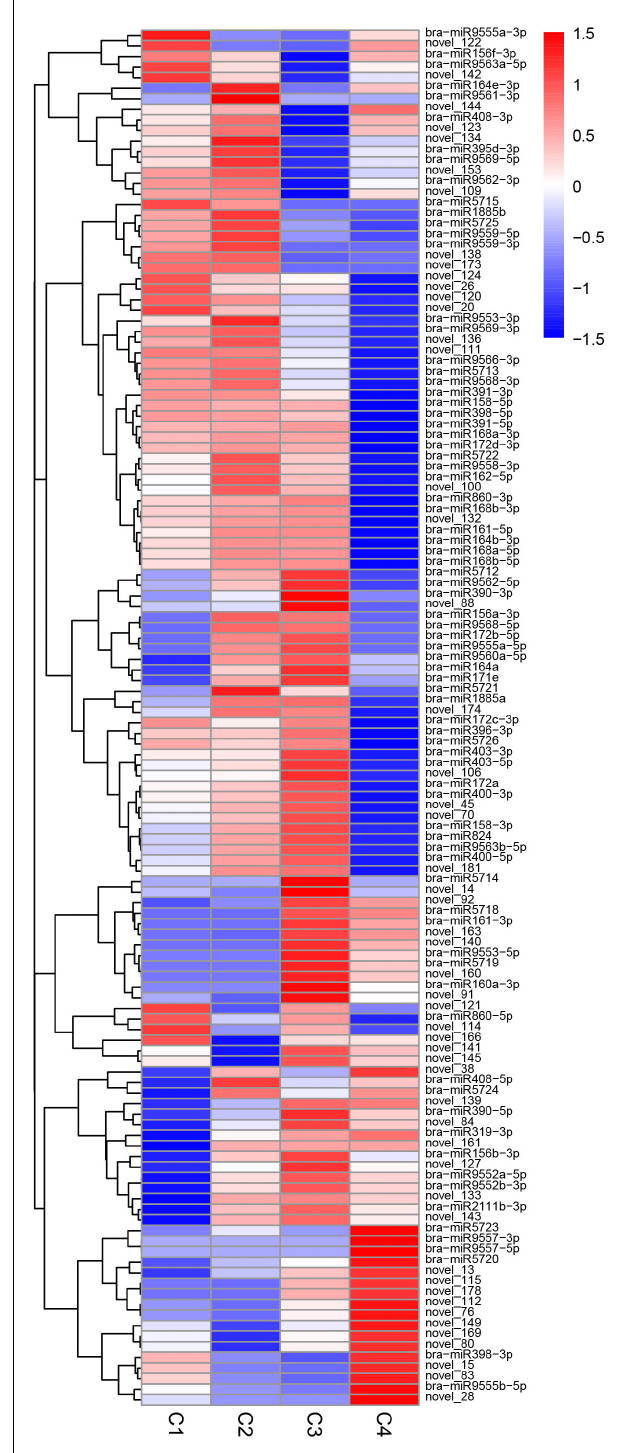
FIGURE 13 | Cluster analysis of differentially expressed miRNA. The above figure is the overall hierarchical clustering chart. Clustering is performed by the log 10 (TPM + 1) value. Red indicates high expression miRNA, and blue indicates low expression